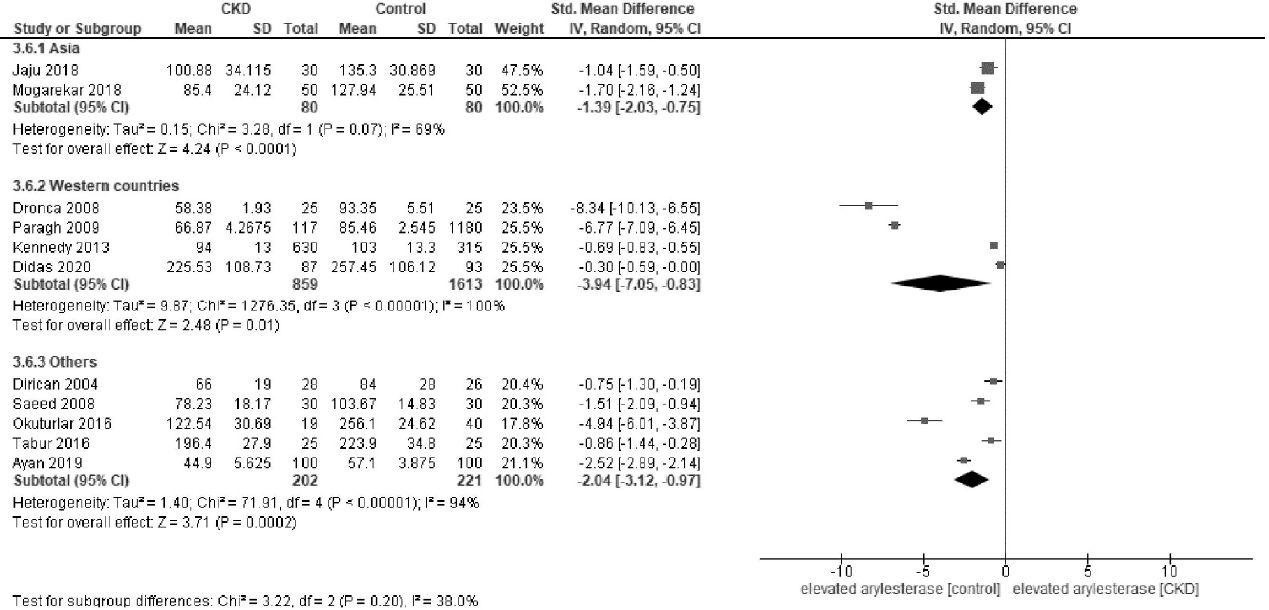
Figure A5. Forest plot of arylesterase activity stratified by regions [28,30,32,34,39,41–43,45–47].